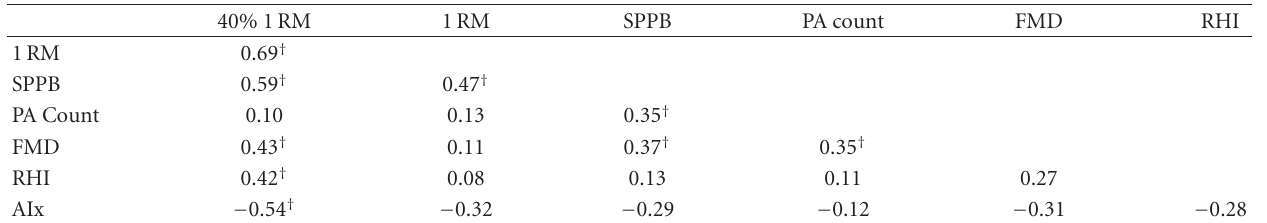
Table 2: Correlation matrix for measures of vascular function and muscle function.